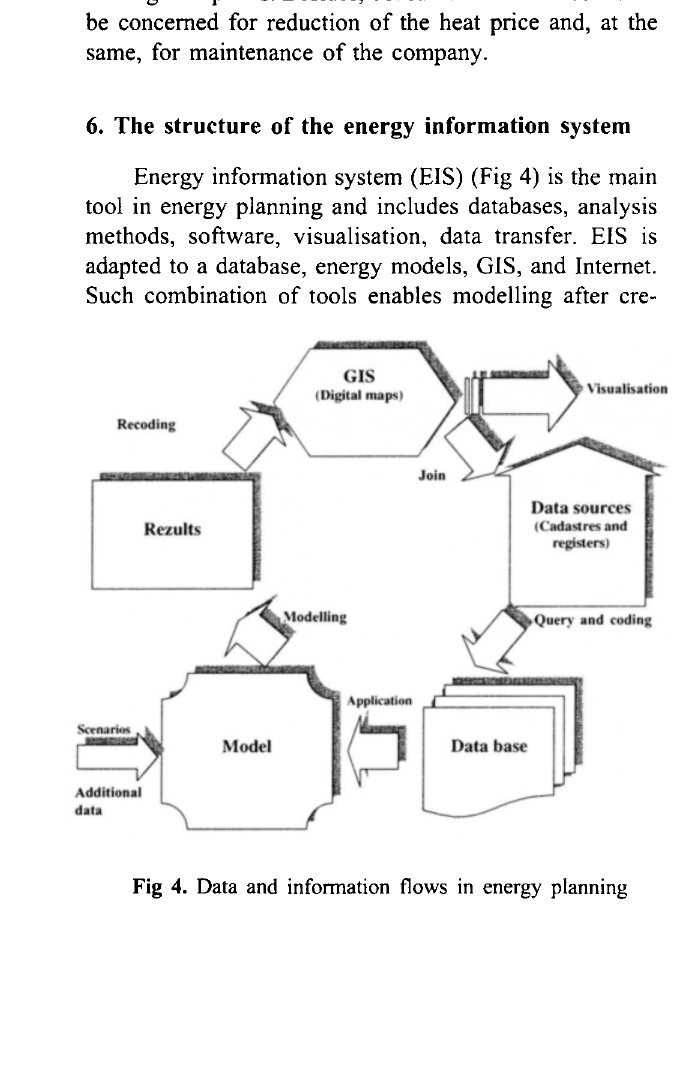
Fig 4. Data and information flows in energy